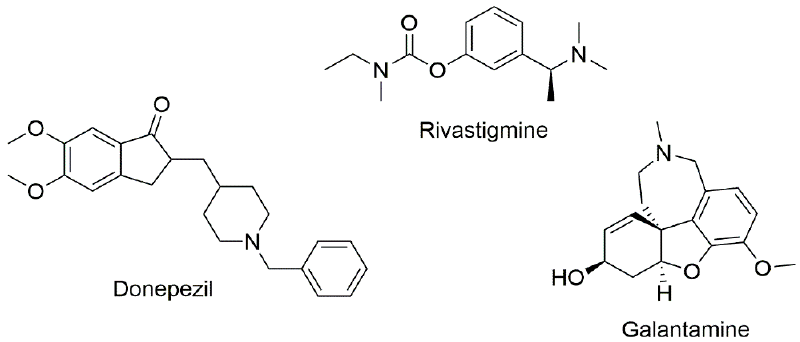
Figure 1. Acetylcholinesterase inhibitors used for the treatment of Alzheimer’s disease.